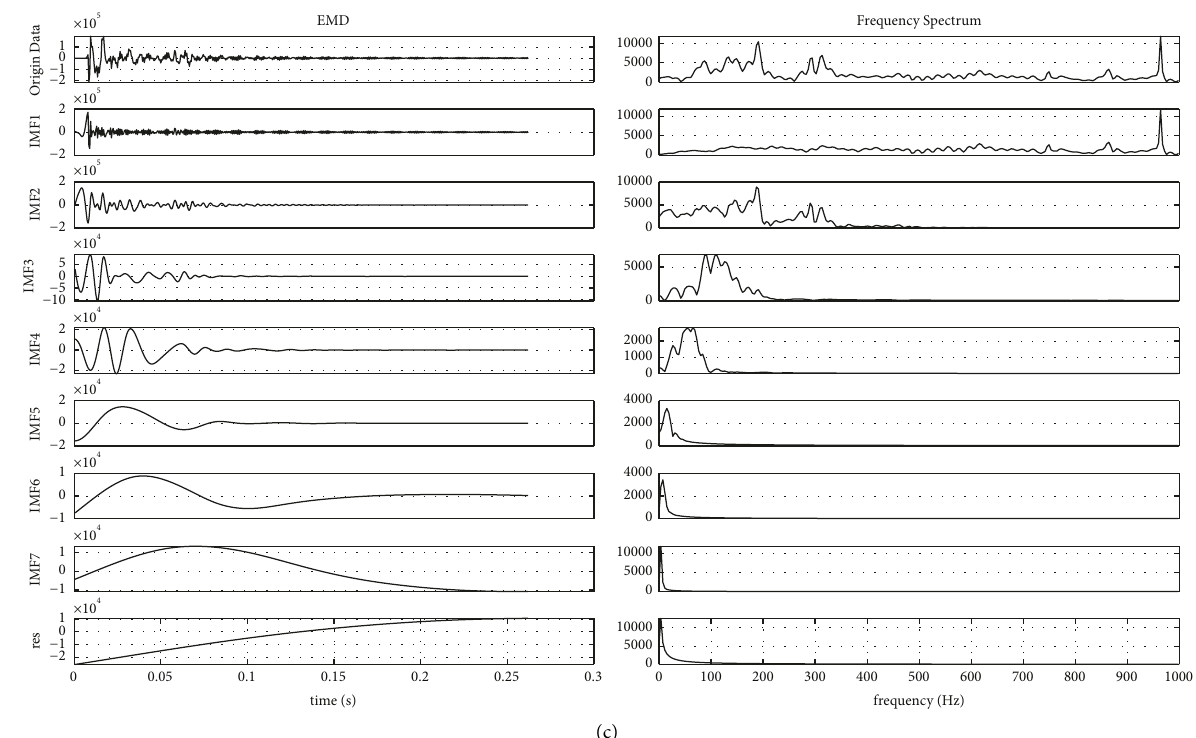
Figure 29: Acceleration signal EMD decomposition and frequency response curve. (a) Tightening preload of 5000 N. (b) Tightening preload of 5000N with one bolt loosened to 3000N. (c) Tightening preload of 5000N with one bolt loosened to 300N.